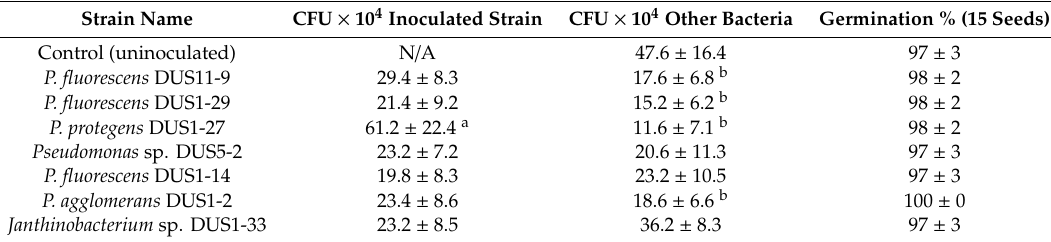
Table 5. Germination e ffi ciency, CFU of inoculated bacteria per g of soil-based medium and total bacterial CFU per g of soil-based medium associated with canola grown in sterilised soil-based medium for 91 days in a glasshouse system with media (soil) maintained at 4% water activity. For each strain, 1 × 10 3 CFU per 50 seeds of each strain were adhered to seeds using a xanthan gum and alginate based sticker 24 h prior to sowing. “a” denotes CFU of P. fluorescens DUS1-27 present in soil medium after 91 days as being significantly higher ( p < 0.05) than CFUs of other inoculated strains after 91 days. “b” denotes soil samples where the CFU of “other bacteria” in the growth medium is significantly lower ( p < 0.05) compared to that of the CFU bacteria quantified from soil of the uninoculated control